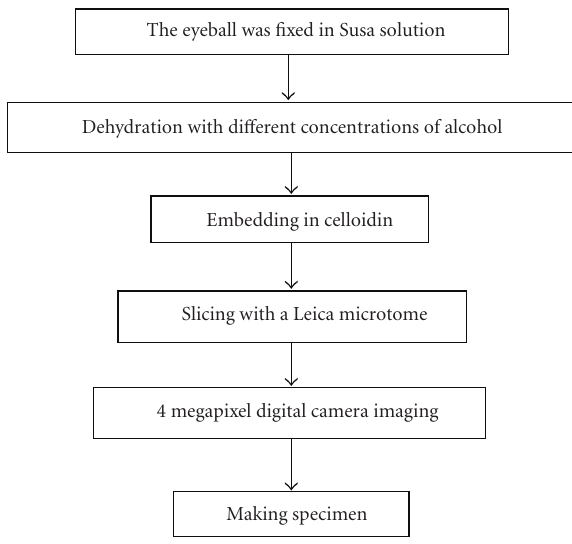
Figure 1: Human eye slice image production